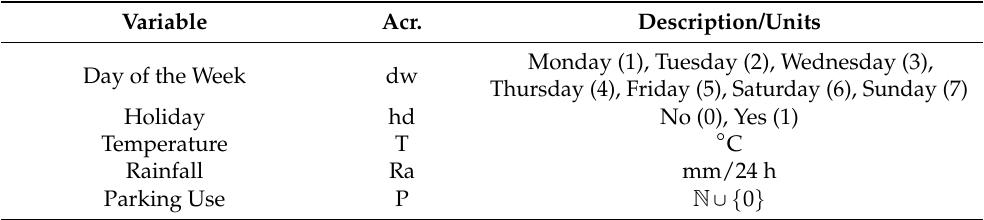
Table 3. Variables involved in the San Sebastian parking occupancy prediction problem.